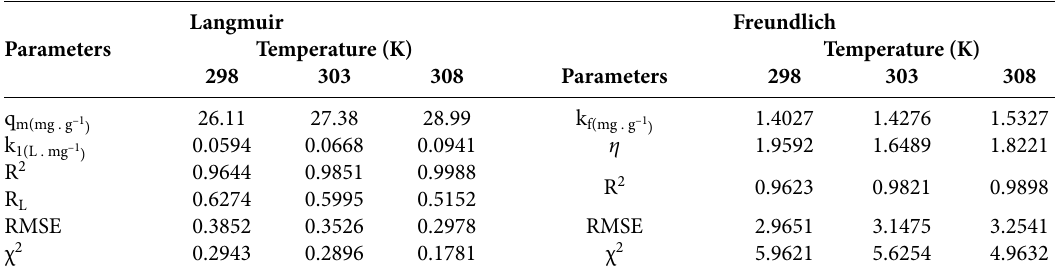
Table 5. Isotherm parameters for As(v) adsorption on pH = 6.5, adsorbent dosage = 700mg/L,contact time = 60 min at different temperatures onto the CMC-EPI/INC